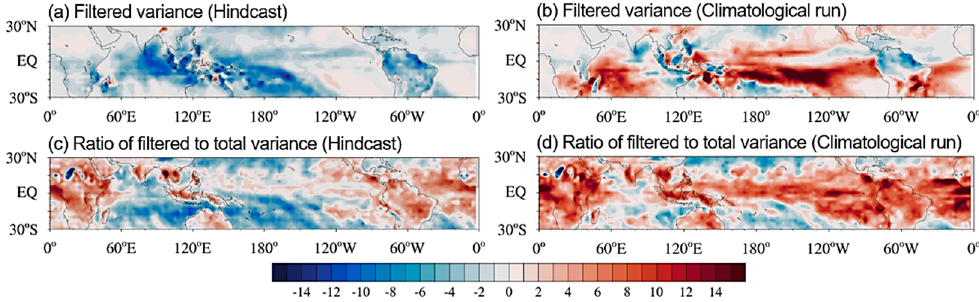
Figure 2. Biases of 20–70 days filtered precipitation (mm − 2 day − 2 ) and the ratio of filtered to the total variance from GS5 hindcast ( a,c ) and GS5 climatological run ( b,d ). The shading represents statistically significant areas (95% confidence level).